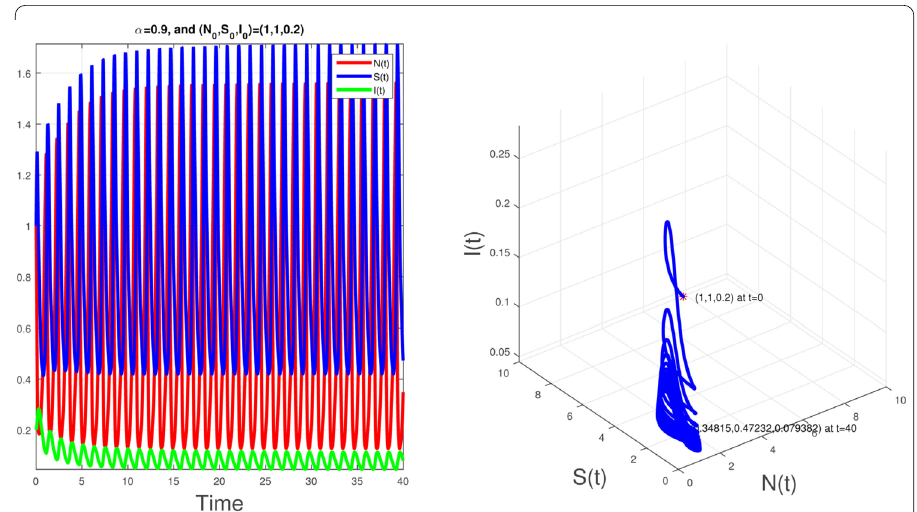
Figure 6 Persistence of the three populations in the case of the instability of EE